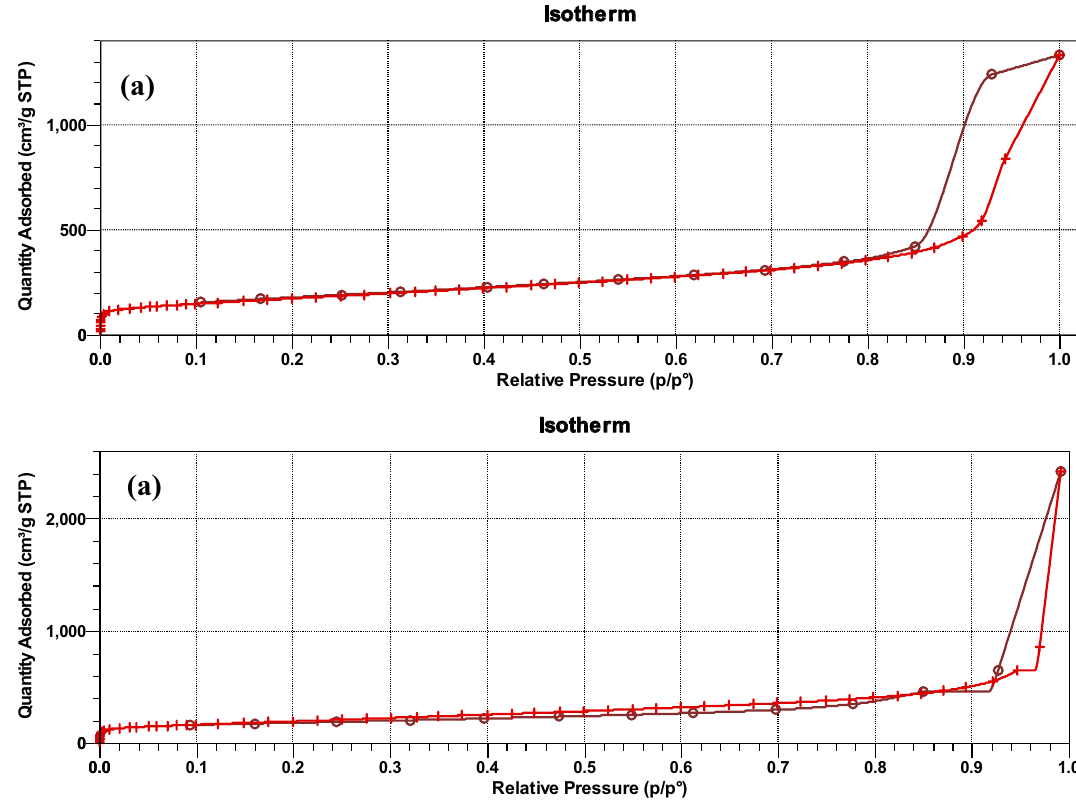
Fig. 3 Isotherms obtained for carbon aerogels prepared using sodium carbonate catalyst ( a ) and lithium perrhenate catalyst ( b